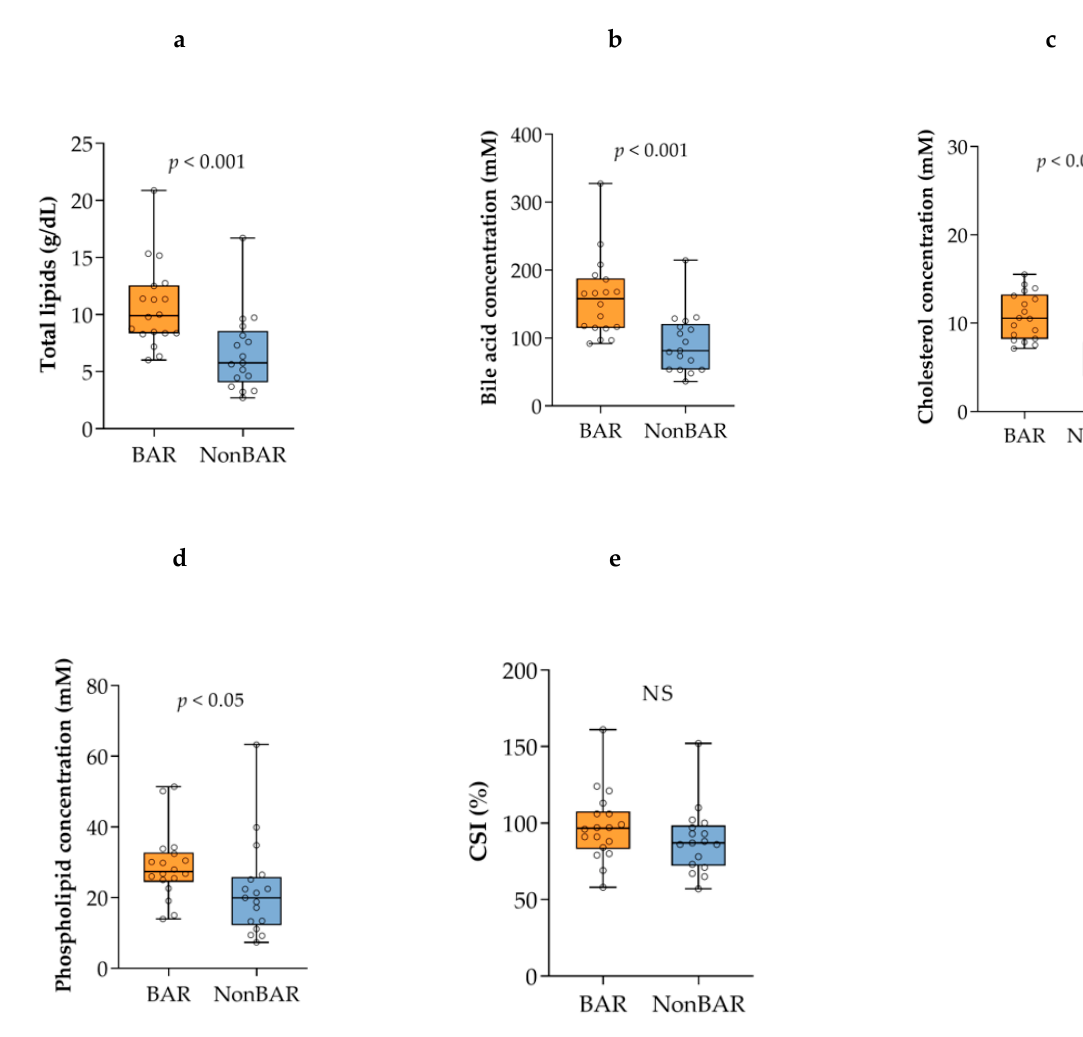
Figure 1. Lipids in gallbladder bile are shown as box and whisker plots, with orange plots indicating bariatric gallstone patients, and blue plots indicating gallstone patients: ( a ) total lipids; ( b ) bile acid; ( c ) cholesterol; ( d ) phospholipid; ( e ) CSI. The horizontal line indicates the median, box borders indicate the lower and upper quartiles, whiskers indicate the minimum and maximum values, and the dots indicate the individual values. CSI: cholesterol saturation index, NS: